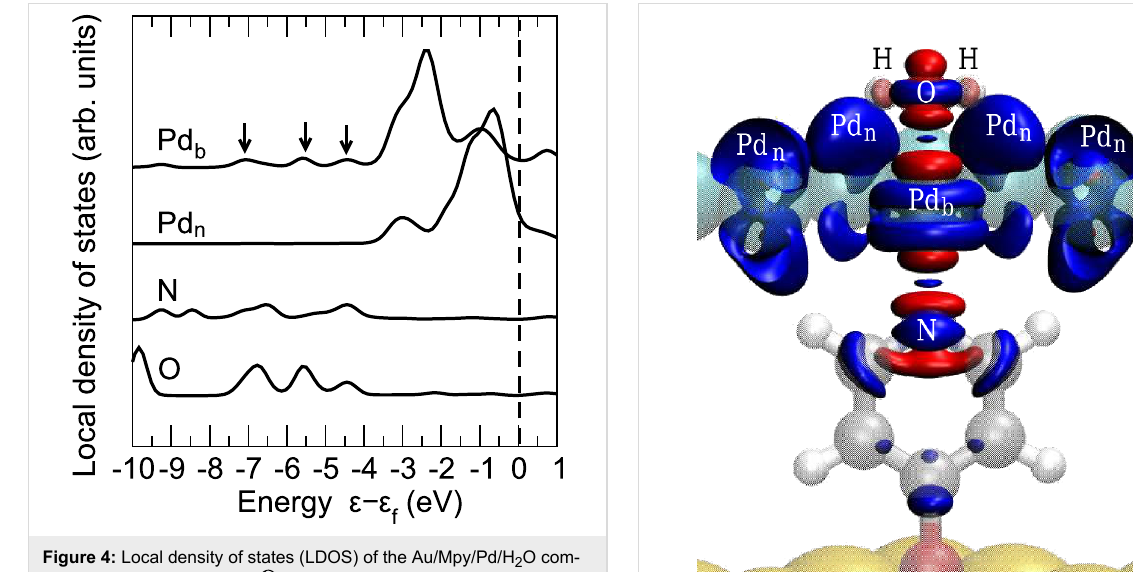
Table 2: Bader analysis of the total electronic charge depletion/accumulation in the Au slab, the 4-mercaptopyridine molecule, the palladium layer (in parenthesis: Charge localized on the Pd b atom only), and the water layer (H 2 O) within the Au/Mpy/Pd, Au/Mpy/Pd/H 2 O, and Au/Mpy/ Pd/( )H 2 O complexes. The partial charge excess/deficiency, in electrons ( e ), is defined relative to the uncharged subsystems.